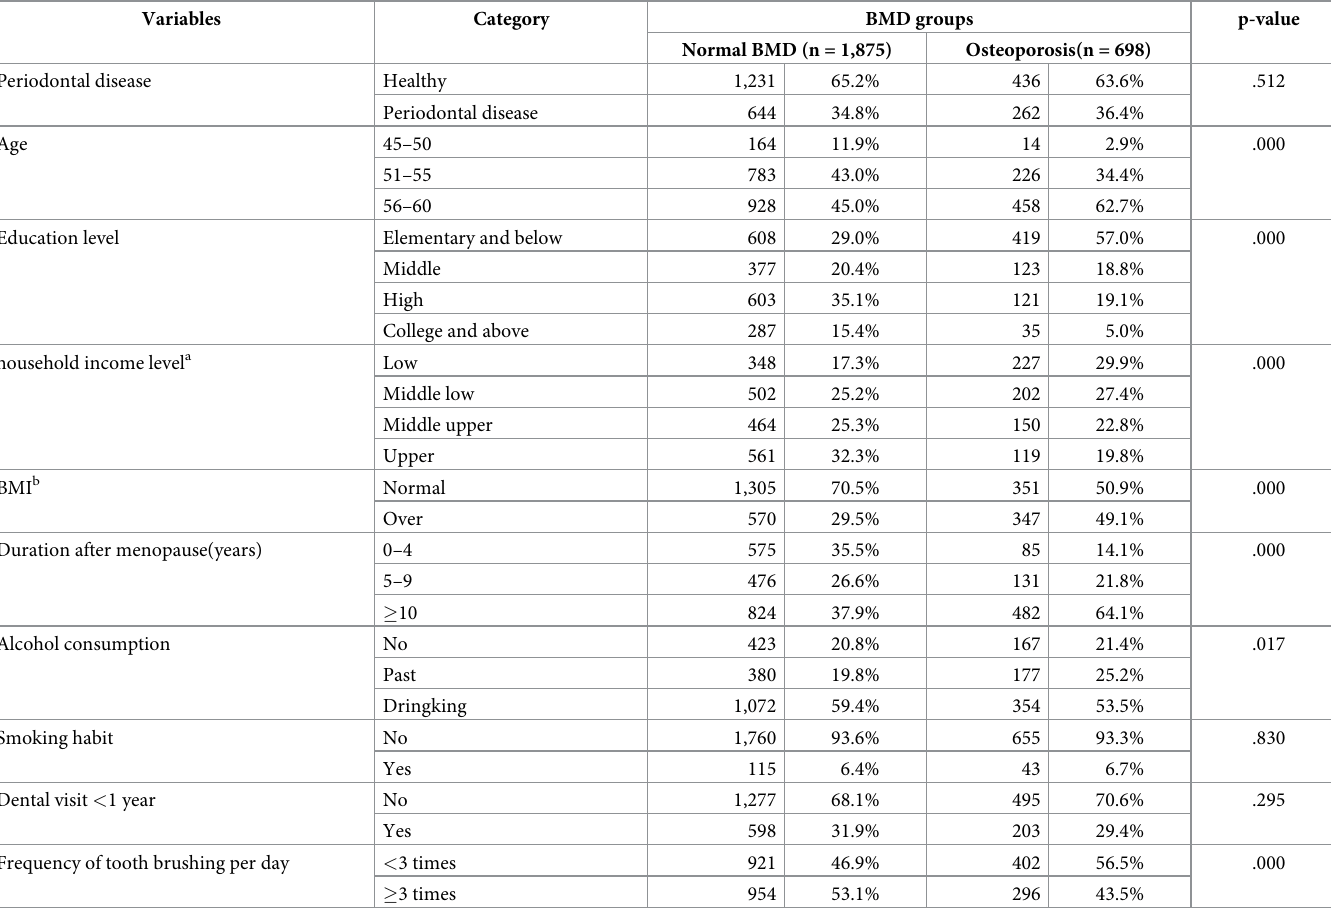
Values are presented as n (weighted %).